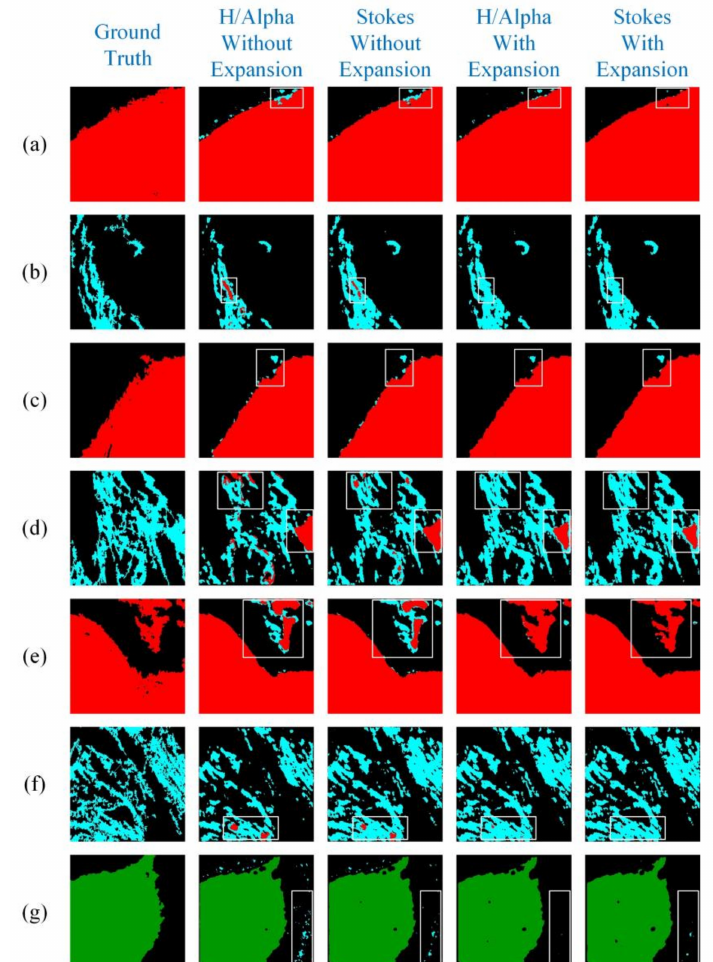
Figure 13. Classification results of several samples using polarized parameters and image stretching. Red represents oil spill, blue represents look alike, while green represents land areas. ( a ) oil spill, ( b ) look alike, ( c ) oil spill, ( d ) look alike, ( e ) oil spill, ( f ) look alike, ( g ) land. Table 13. IoU and MIoU values of validation experiments with and without image stretching. Image Stretching Clean Sea Oil Spill Look Alike Land Ship MIoU Without 86.2% 83.1% Image 2